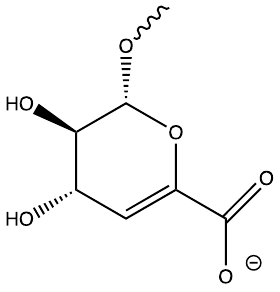
Figure 2. Non-reducing end of